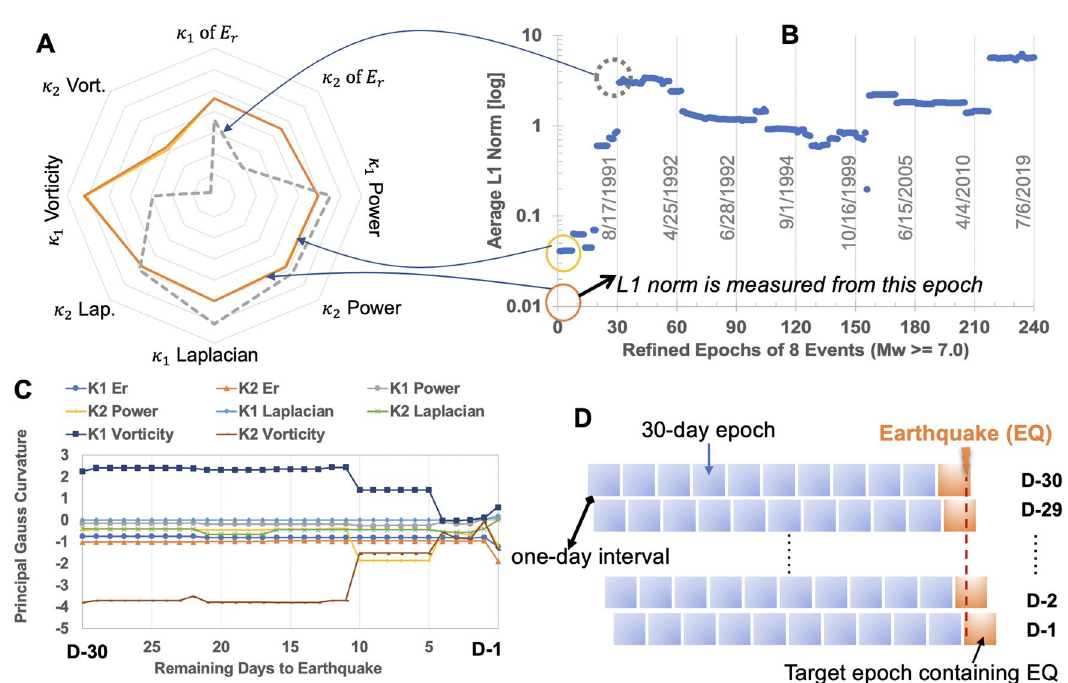
Figure 5. Preliminary investigation results with refined epochs with one-day interval. 10-years data one month before target earthquake (EQ) are used. ( A ) Radial plot of the principal Gauss curvatures of the pseudo physics quantities. Orange and yellow lines nearly overlap each over and indicate mutual similarity due to the same target EQ (8/17/1991) whereas dashed gray line corresponds to different target earthquake (4/25/1992) showing a noticeable discrepancy. (B) Average L1 norm of large earthquakes showing the relative similarity among 30 epochs before the same target EQ and the difference from epochs associated with other target EQs. (C) Temporal variations of 8 principal Gauss curvatures of the refined epochs before EQ (8/17/1991). (D) Visual explanation of the refined one-day interval of consecutive epochs.